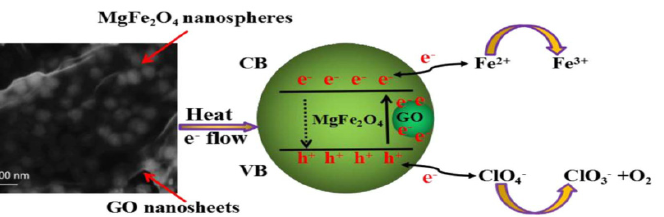
Figure 15. Schematic diagram of thermal catalytic activity mechanism of GO coated MgFe 2 O 4 composite. Reprinted with permission from ref. [44]. Copyright 2013 AIP